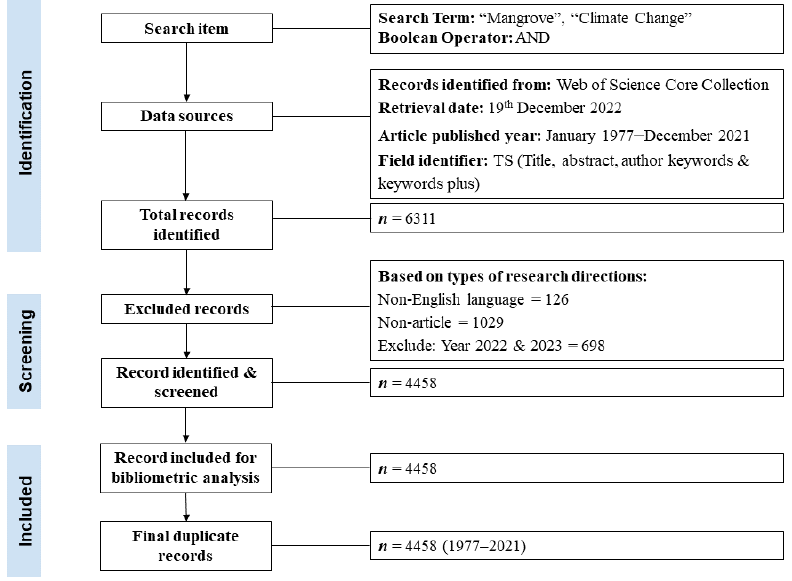
Figure 1. The framework of the present study of climate change and mangrove forests.